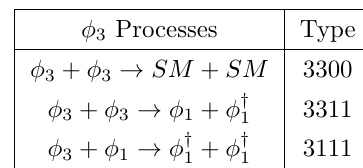
Figure 2 . Semi-annihilation processes in the Z 4 model, which are generated by the µ S 1 interaction along with one Higgs portal interaction.